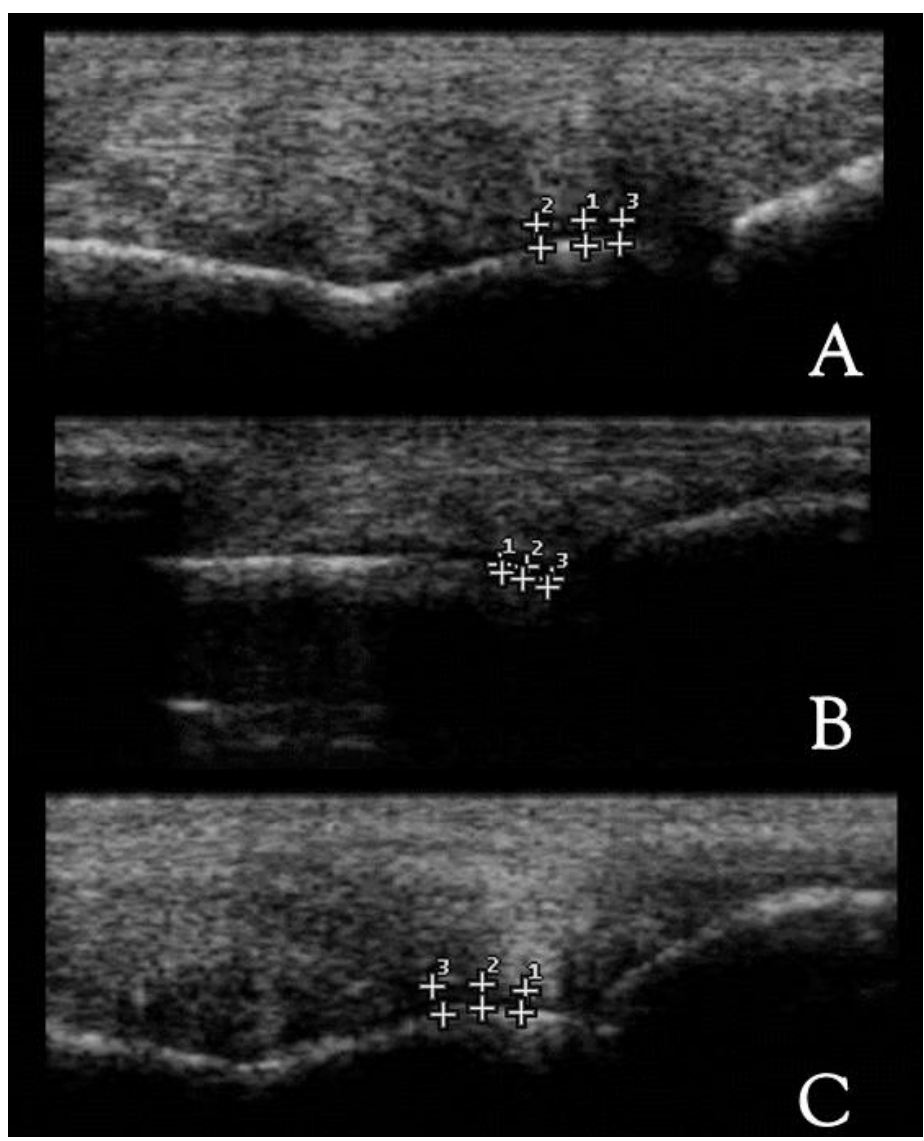
Figure 1. Longitudinal ultrasound views from a thoroughbred MCP joint. ( A ) Dorsal, ( B ) dorso- lateral and ( C ) dorso-medial scans; (1, 2, 3) cartilage thickness consecutive measurements. Proximal is to the left. B-mode, linear probe, 7.5